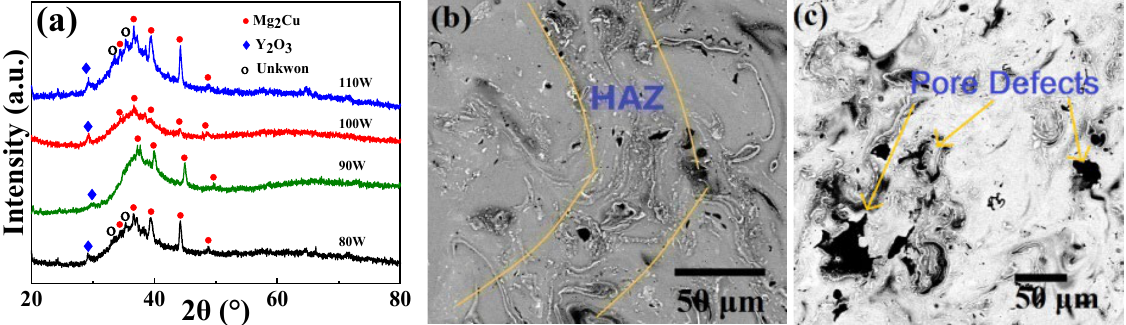
Figure 4. XRD and SEM of 3D-printed Mg-based metallic glasses with scanning speed of 1000 mm/s: ( a ) XRD of the samples with different laser power. ( b ) SEM of the cross-section with laser power of 110 W. ( c ) SEM of the cross-section with laser power of 80 W.